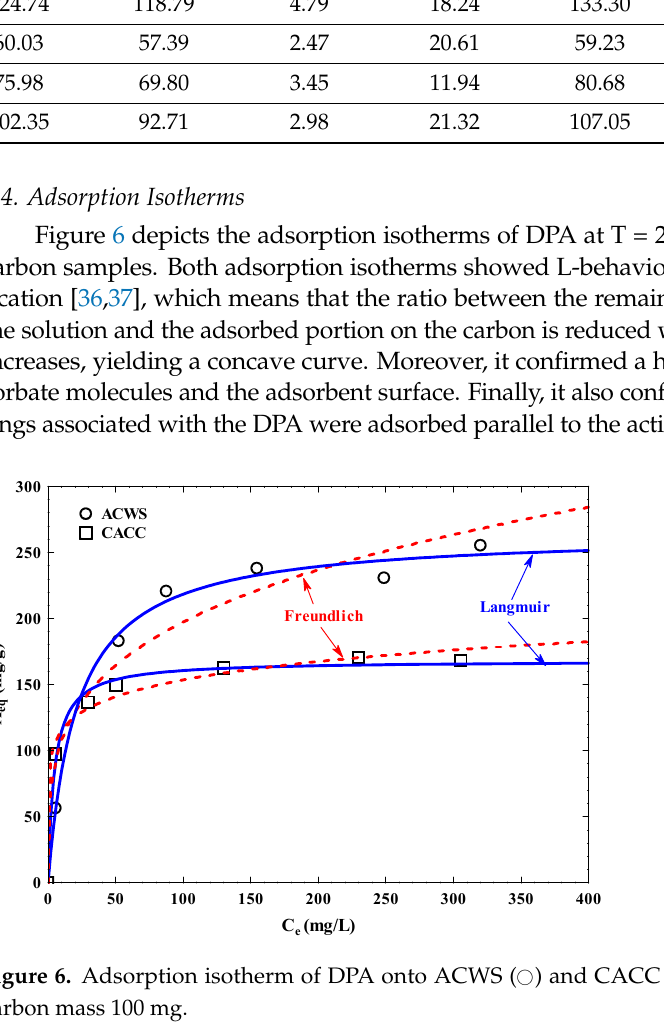
) and CACC ( (cid:3) ) at T = 25 ◦ C, pH ≈ 5 and (cid:35)